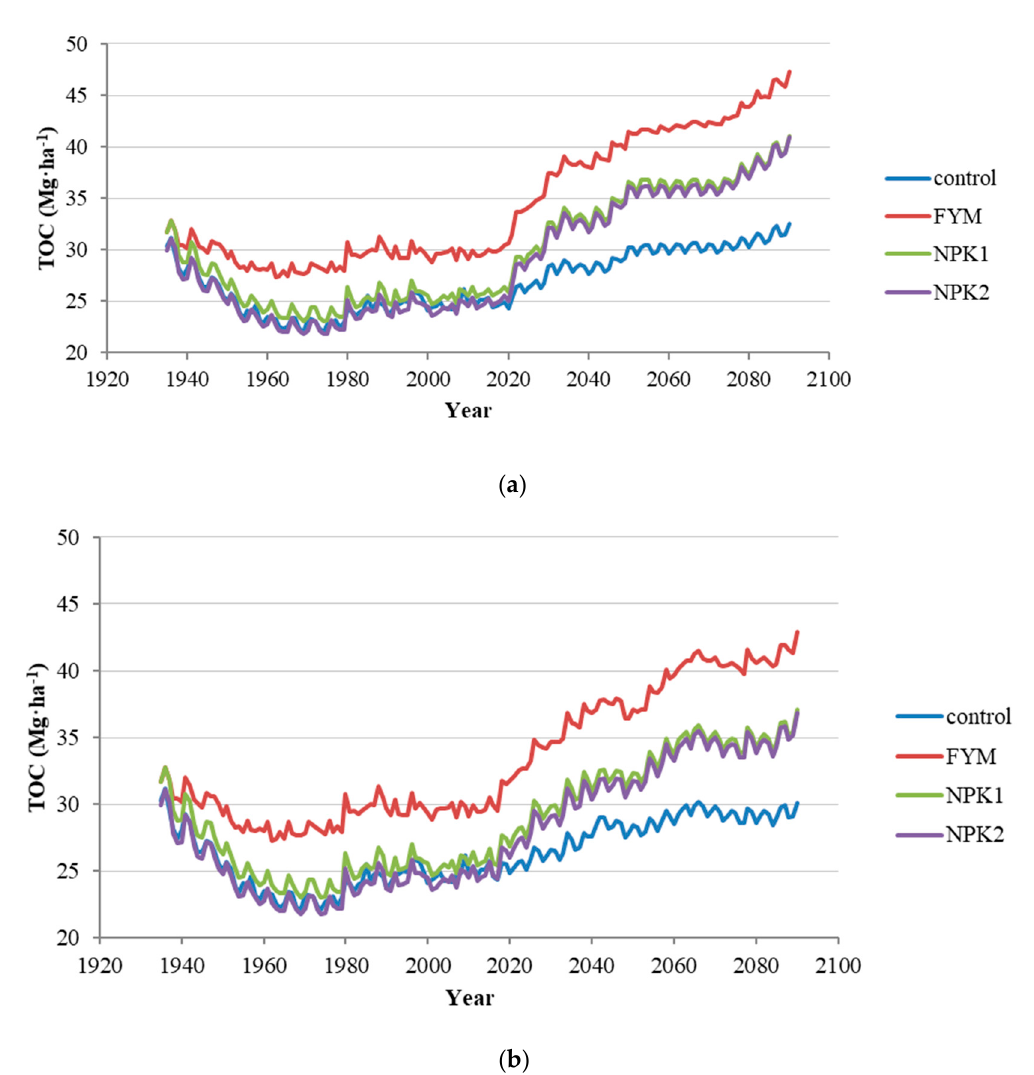
Figure 7. Simulated annual dynamics of the total SOC stocks in the DAOS 4 experiment (1933–2090): ( а ) RCP4.5 and ( b ) RCP8.5.